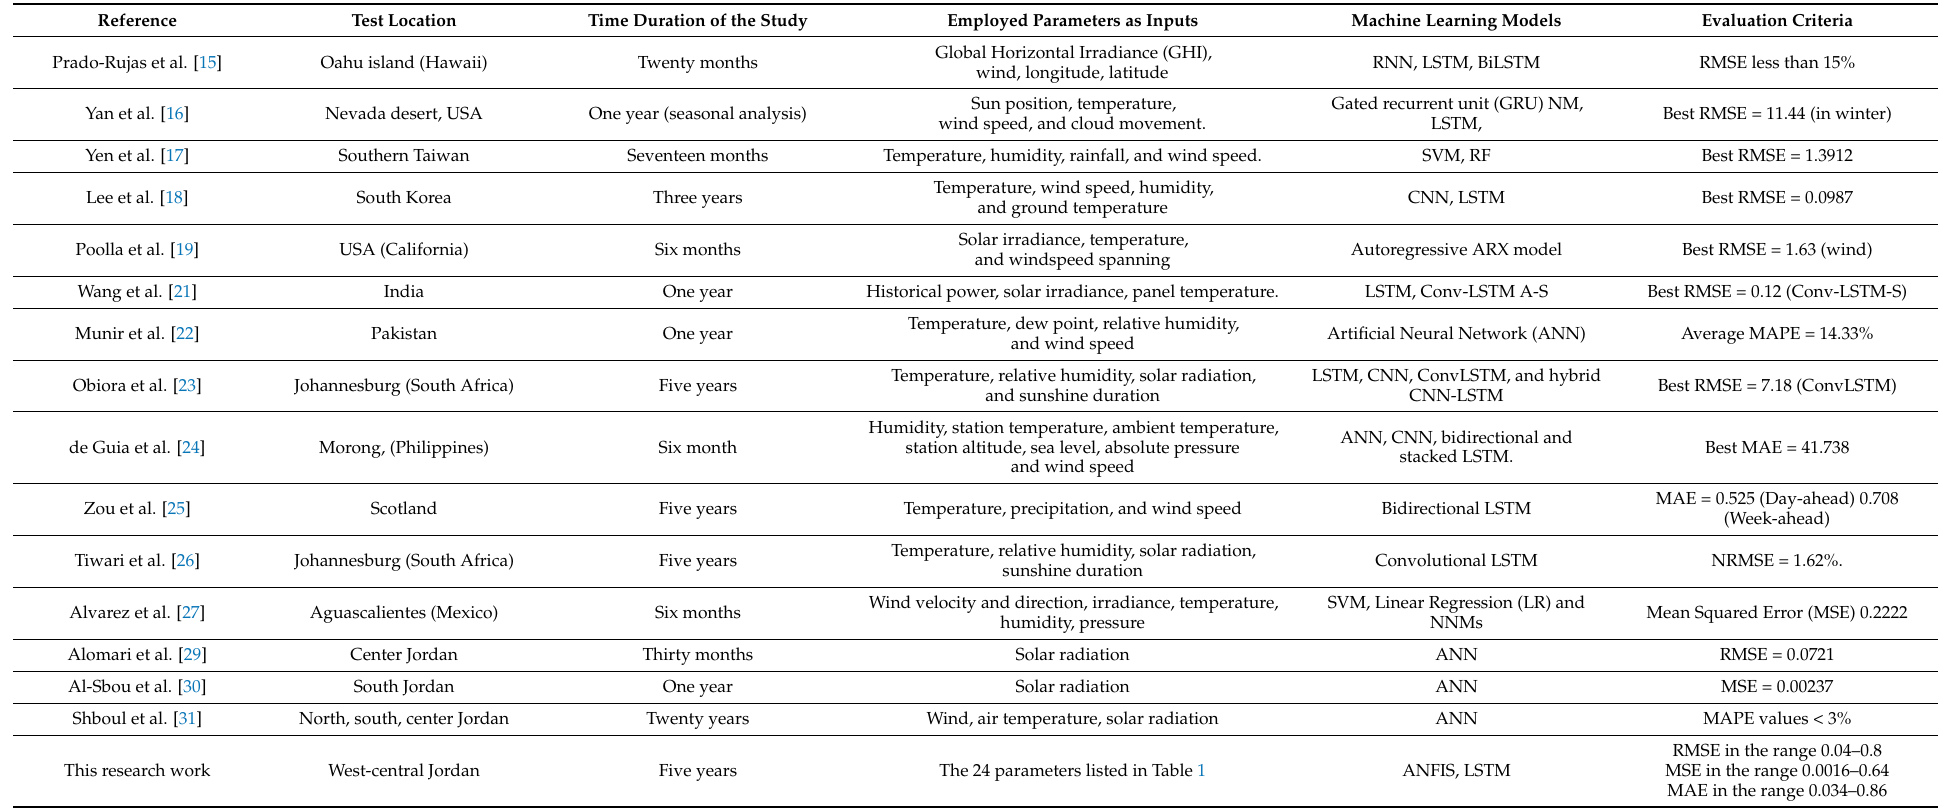
Table 5. Comparison analysis of the research studies reported in the literature with the proposed one in this work related to solar radiation forecasting carried out in the Jordanian territory and